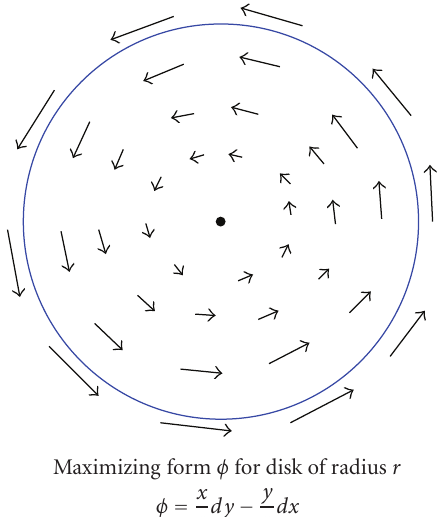
Figure A.3. A maximizing form for the disk in 2D. This form satisfies the constraints as long as 2 /r ≤ λ . The λ is, of course, the scale in the flat norm with scale introduced